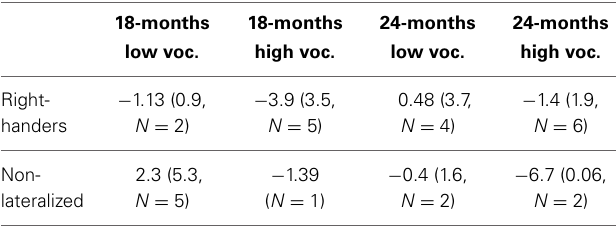
Table 2 | N400 effect (in µ V) over the right hemisphere as a function of vocabulary and